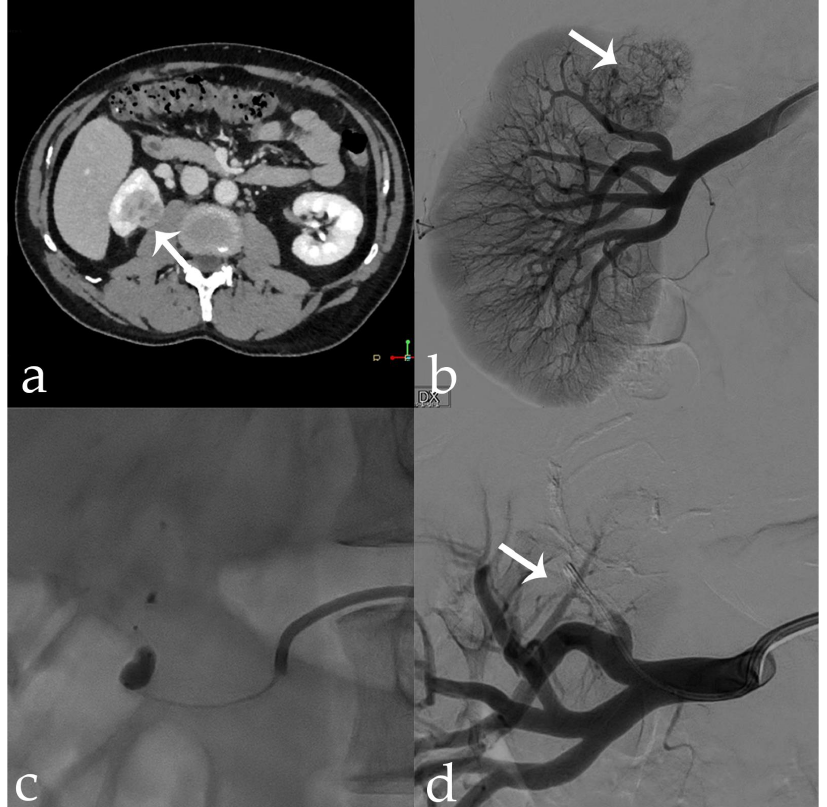
Figure 6. 56 yr old male with endo-exophytic RCC of the right kidney upper pole (30 × 20 mm): ( a ) pre-operative CECT; ( b ) pre-embolization DSA showing tumor vascular supply (arrow); ( c ) embo- lization procedure using stop-flow technique after super selective setting with a microcatheter-balloon inflated during 18-Onyx and indocyanine mixture administration; ( d ) post-procedural DSA showing complete tumor devascularization (arrow).